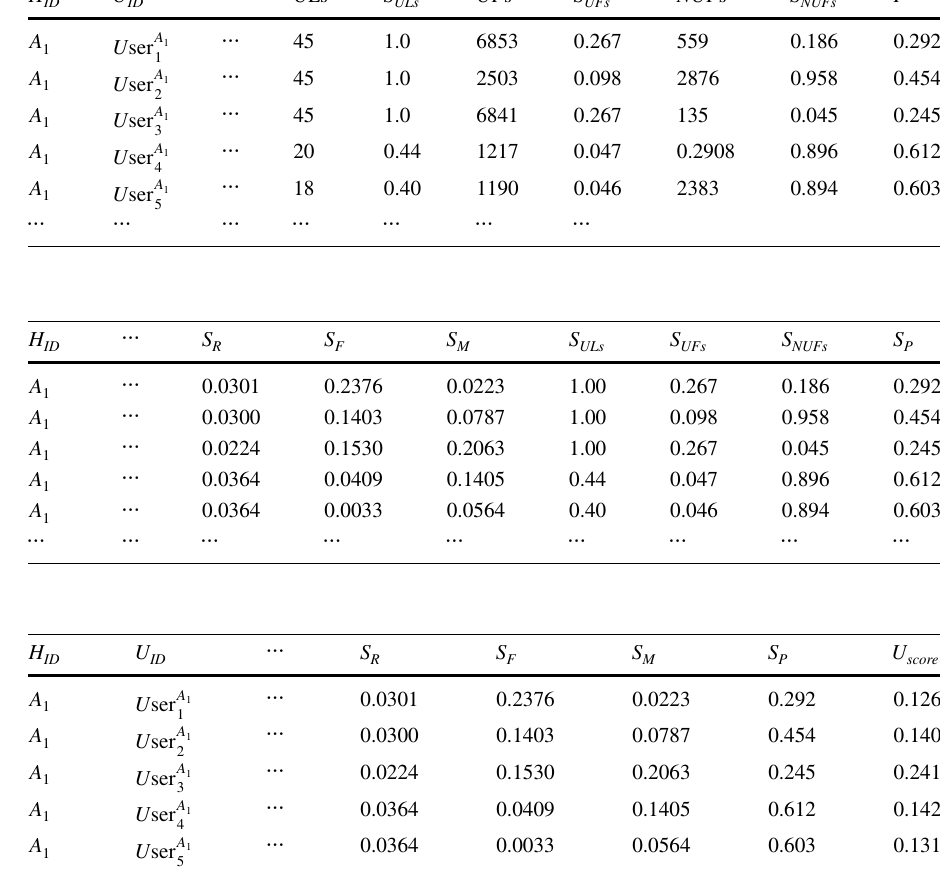
Table 6 User popularity score P